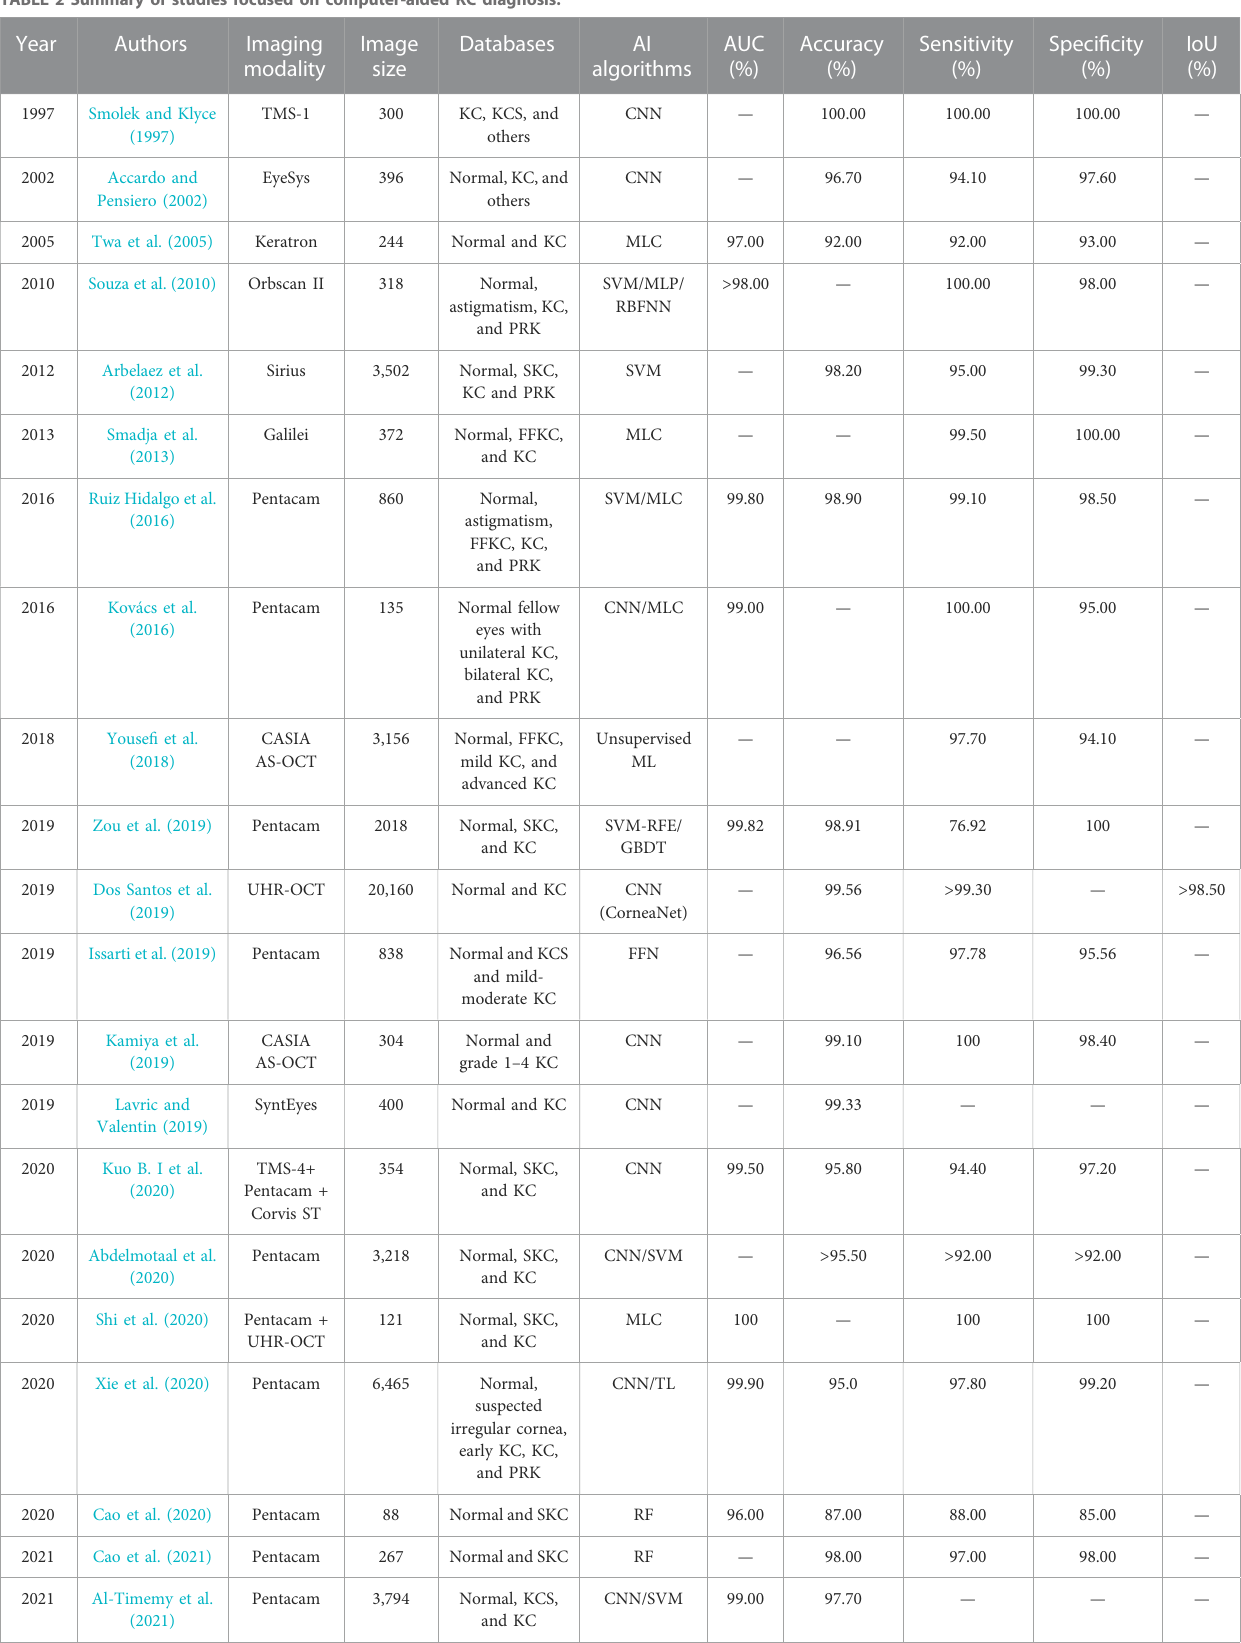
TABLE 2 Summary of studies focused on computer-aided KC